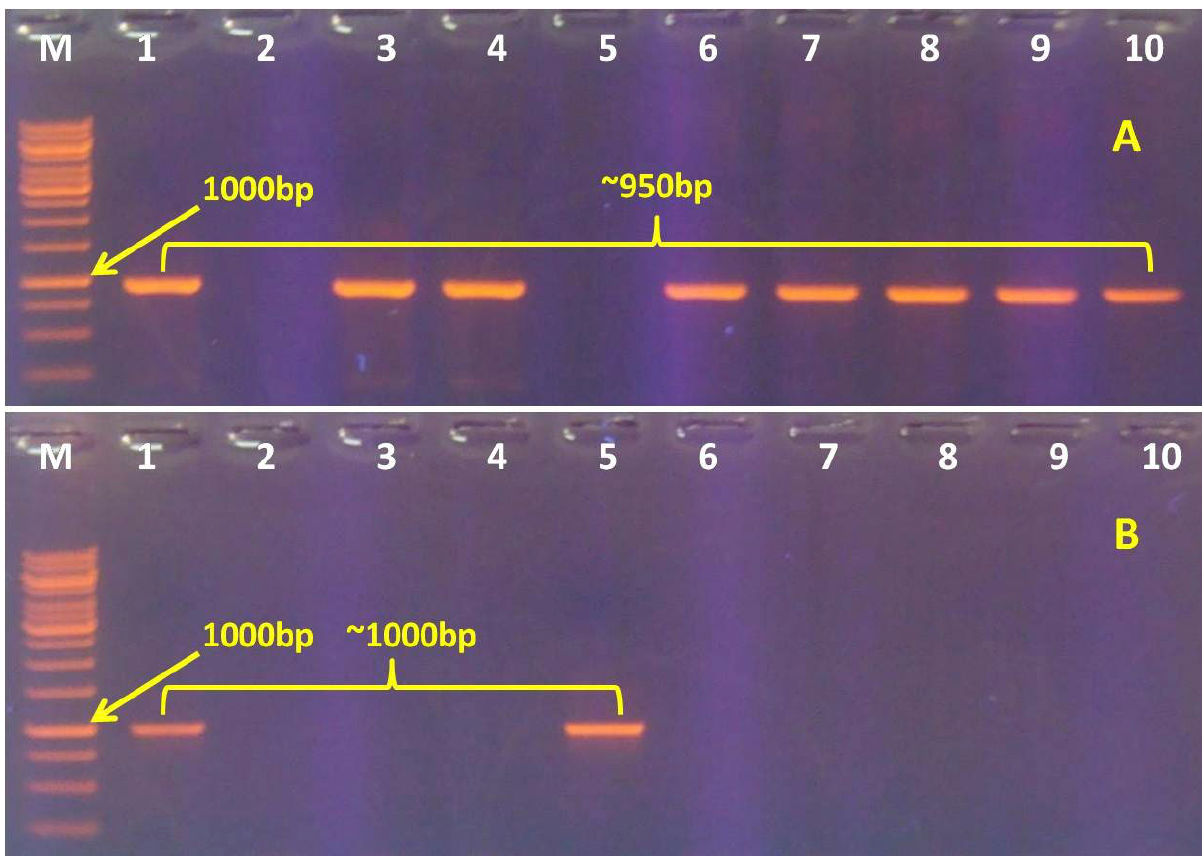
Figure 2. Gel photograph of some of the yellow mosaic disease samples of wild Vigna processed for MYMIV and MYMV detection with specific primers NM1/NM2 (A) and MYMV-CPF/MYMV-CPR (B), respectively. M=DNA ladder (1 kb), Lane 1=Positive control (DNA was extracted from symptomatic leaves, cv. Barabanki local), Lane 2=Negative control (No DNA was added in PCR mix), Lane 3=IC277019, Lane 4=IC337486, Lane 5=IC331450, Lane 6=IC372406, lane 7=IC583700, Lane 8=IC583664, Lane 9=IC583665, Lane 10=IC583666. Out of eight accessions seven showed positive reaction with MYMIV (A) and one with MYMV